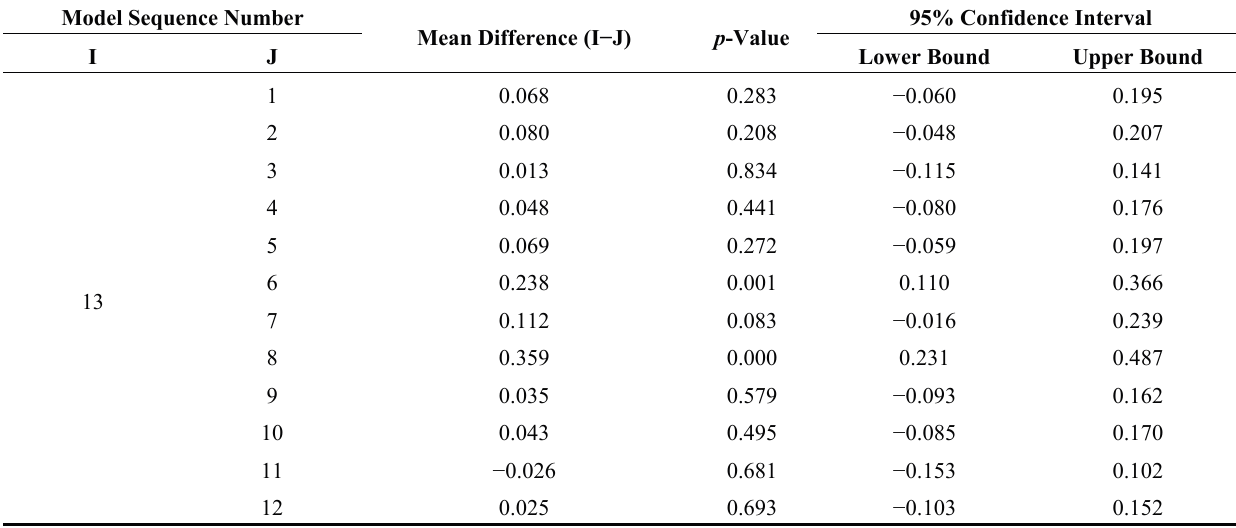
The sequence number 1 − 9 respectively represents SRI1, SRI2, SRI3, NDI1, NDI2, TBI1, TBI2, TBI3 and REP; 10 − 13 represents SMLR, PLSR, SVR and